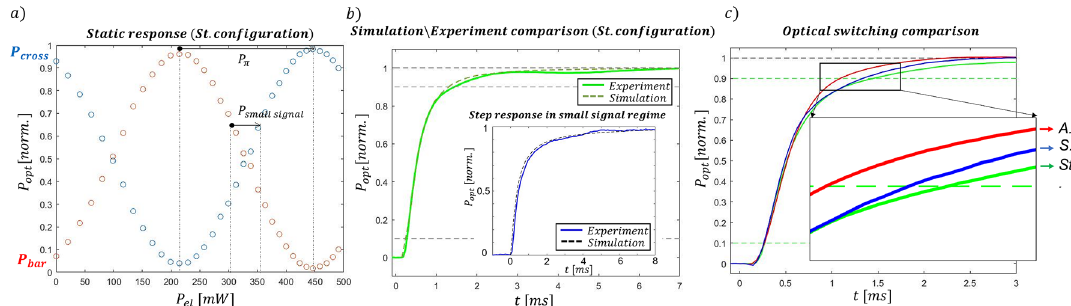
Figure 5. ( a ) Static response of the MZI at increasing values of dissipated power (standard configuration). ( b ) comparison between simulated and experimental switching time and, in the inset, temporal response comparison to a step like applied power in the small signal regime (standard configuration). ( c ) Switching time comparison between the three different configurations: asymmetric (A.), symmetric (S.) and standard